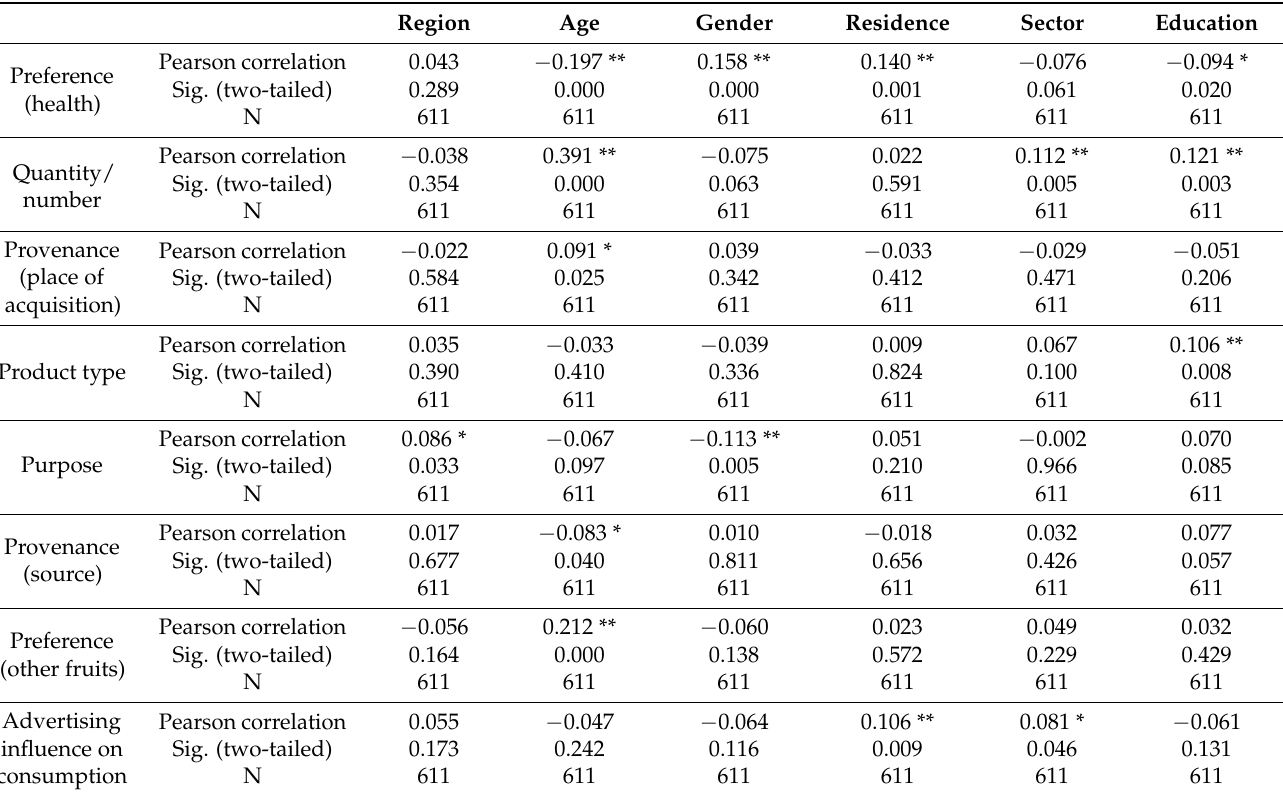
Table 3. The χ 2 contingency coefficient (chi-square tests) and the Pearson correlation coefficient between the main variables. Region Age Gender Residence Sector